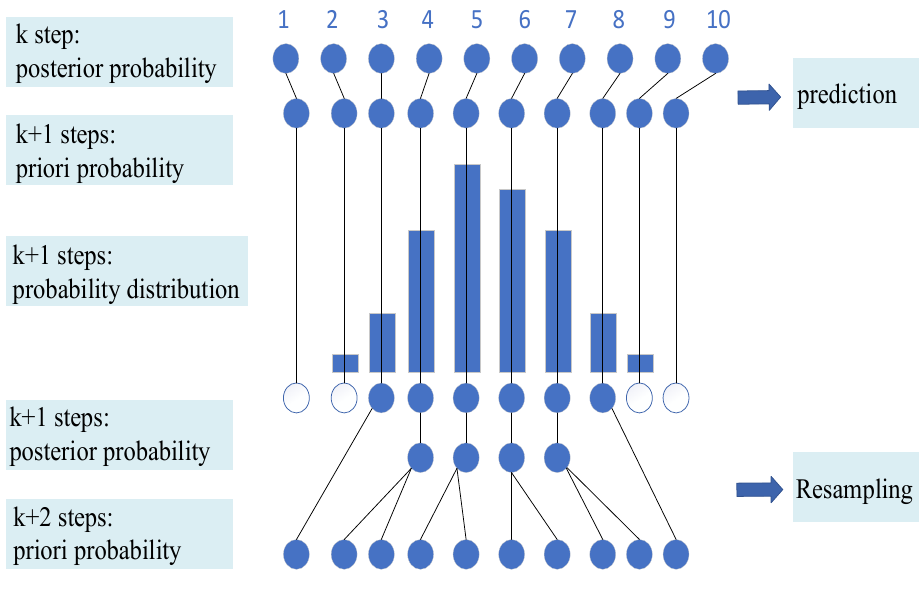
Figure 6. Resampling schematic.